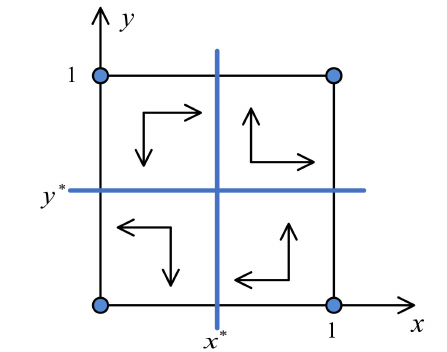
Figure 1. Di ff erent locations of the saddle point ( x ∗ , y ∗ )